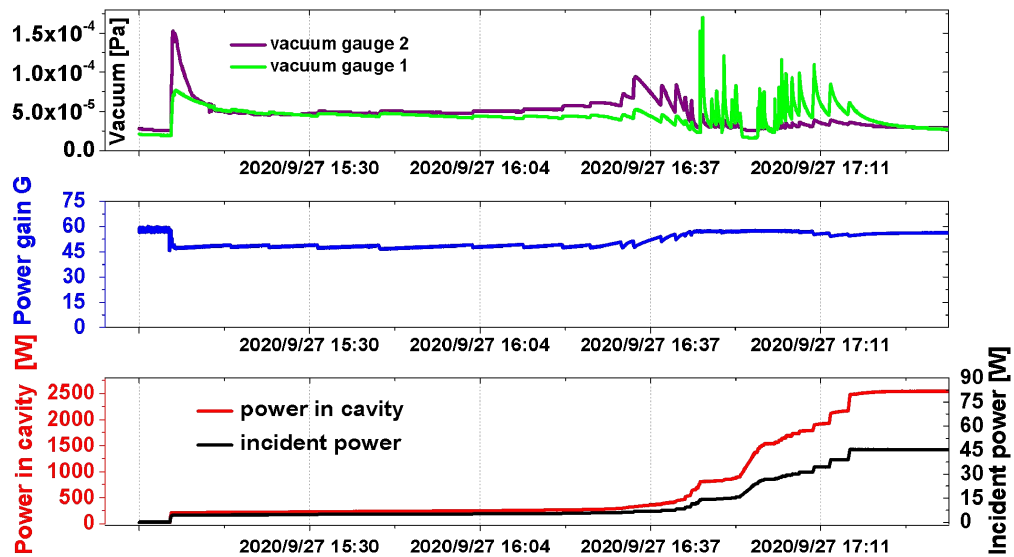
FIG. 22. High-power test results with the left short at z ¼ − 30